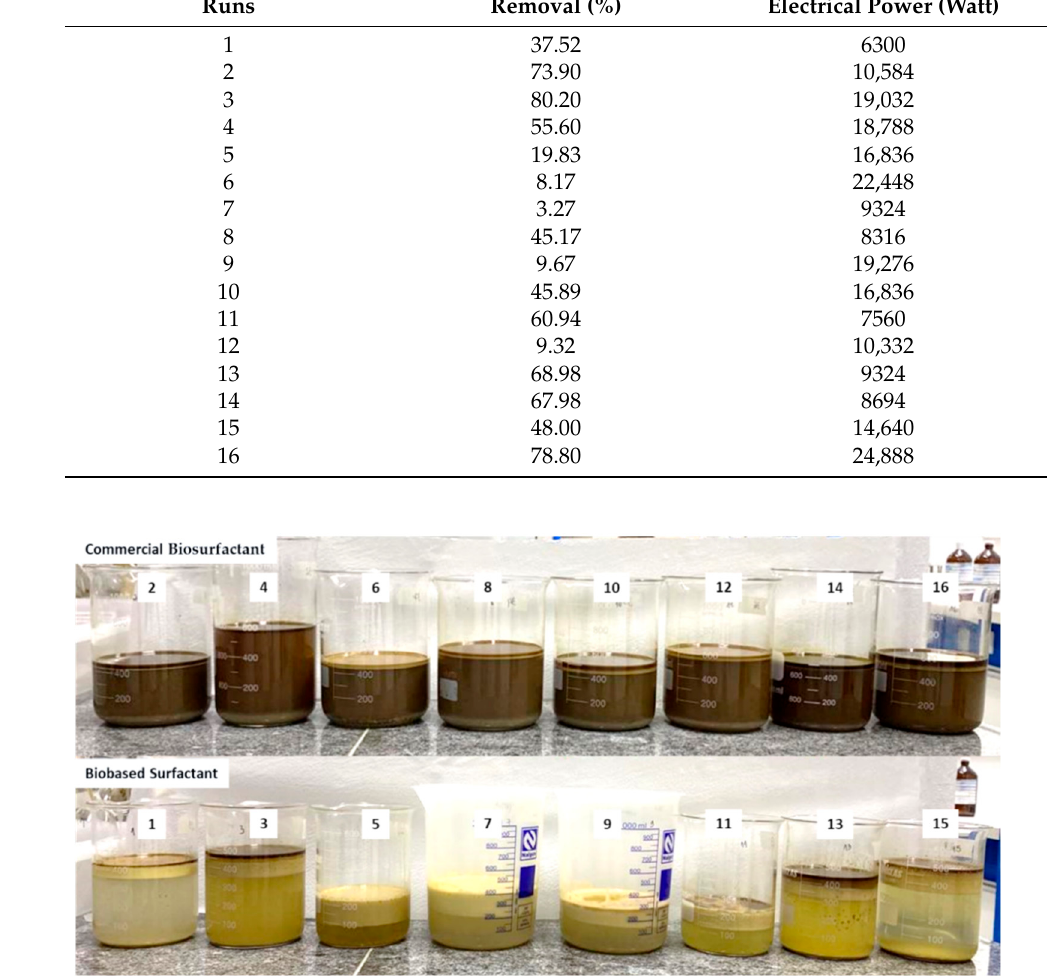
Figure 1. Images of surfactants washing solutions after the experiments of motor oil removal (liquid part: sand + removed contaminant). Numbers (1–16) correspond to experimental runs performed in 2 8-4 Fractional Factorial Design.